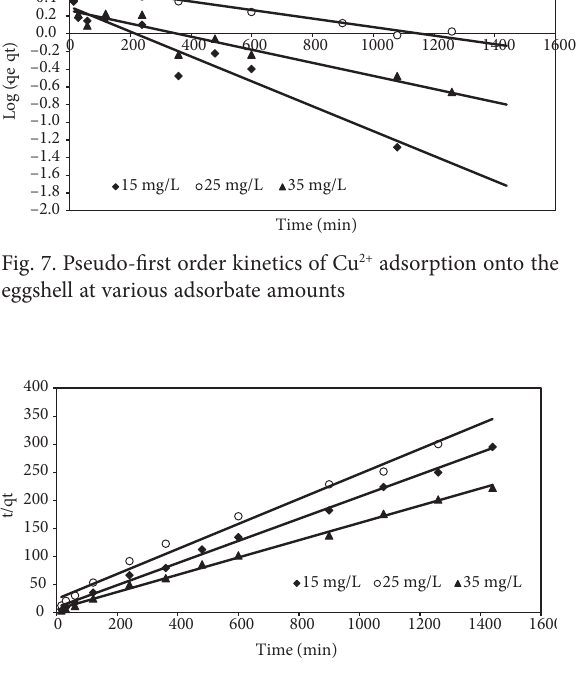
Fig. 8. Pseudo-second order kinetics of Cu 2+ adsorption onto the eggshell at various adsorbate